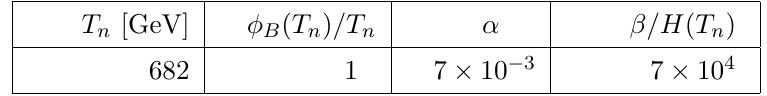
Table 1 . Parameters T ( T ) =T and (cid:12)=H ( T ) for the evaluation of the spectrum of n ; (cid:30) B n n ; (cid:11) n gravitational wave background with the benchmark point (cid:21) = 0 : 05, = 1, (cid:20) 1 = 0 : 05, M b g 3 = 0, v = 0 : 123 and tan (cid:12) = X A =f b t